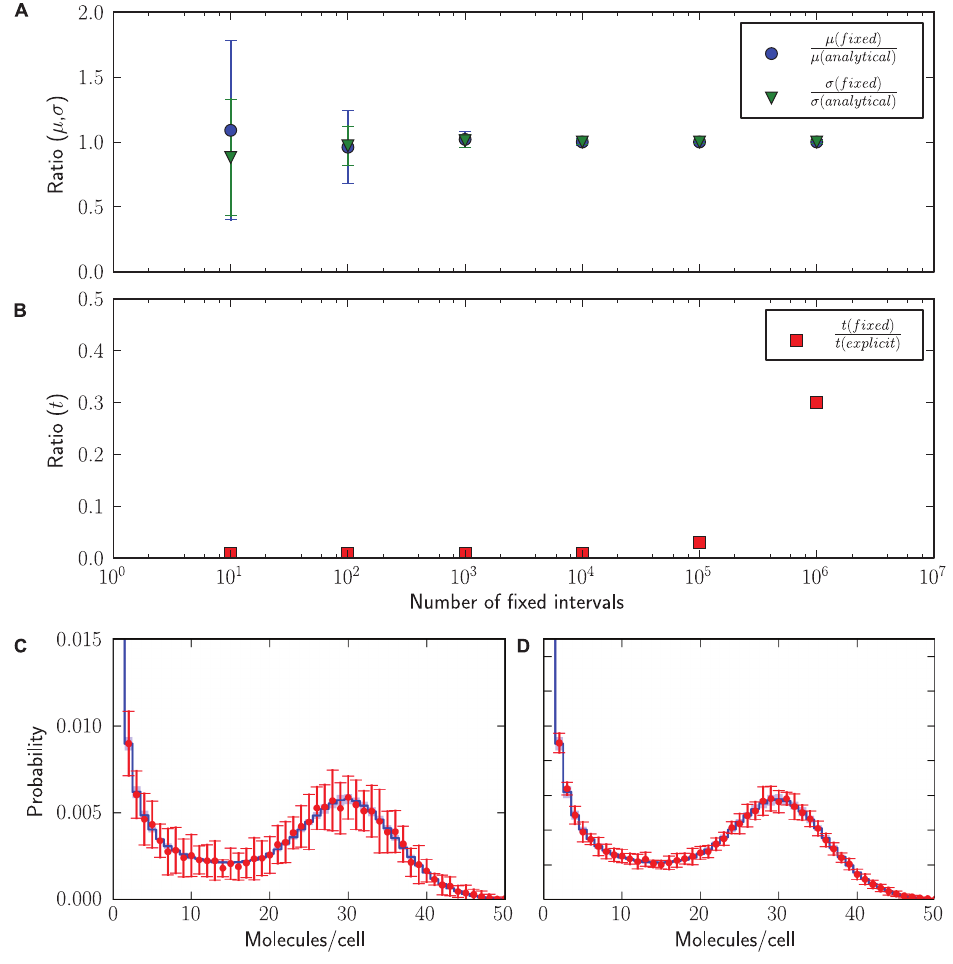
Figure 2. Fixed interval versus explicit simulation output. Hundred stochastic simulations until t=60.000 min ( & 10 6 time steps) were done with k ON ~ 0 : 05 min 2 1 , k OFF ~ 0 : 45 min 2 1 , k syn ~ 80 min 2 1 , and k deg ~ 2 : 5 min 2 1 . (A) Accuracy of mean and standard deviation estimates as function of the number of fixed intervals. (B) Simulation time with fixed-interval output increases with the number of fixed intervals. Fixed-interval simulations were done with the StochPy interface to StochKit2 and include the time to calculate the associated probability distributions. (C) The stationary mRNA distribution for 10 4 fixed intervals (red error bars, 1.96 s ) vs. explicit output (blue 95% confidence interval). Note that 1.96 s corresponds to a 95% confidence interval. (D) The stationary mRNA distribution for 10 6 fixed intervals (red error bars, 1.96 s ) vs. explicit output (blue 95% confidence